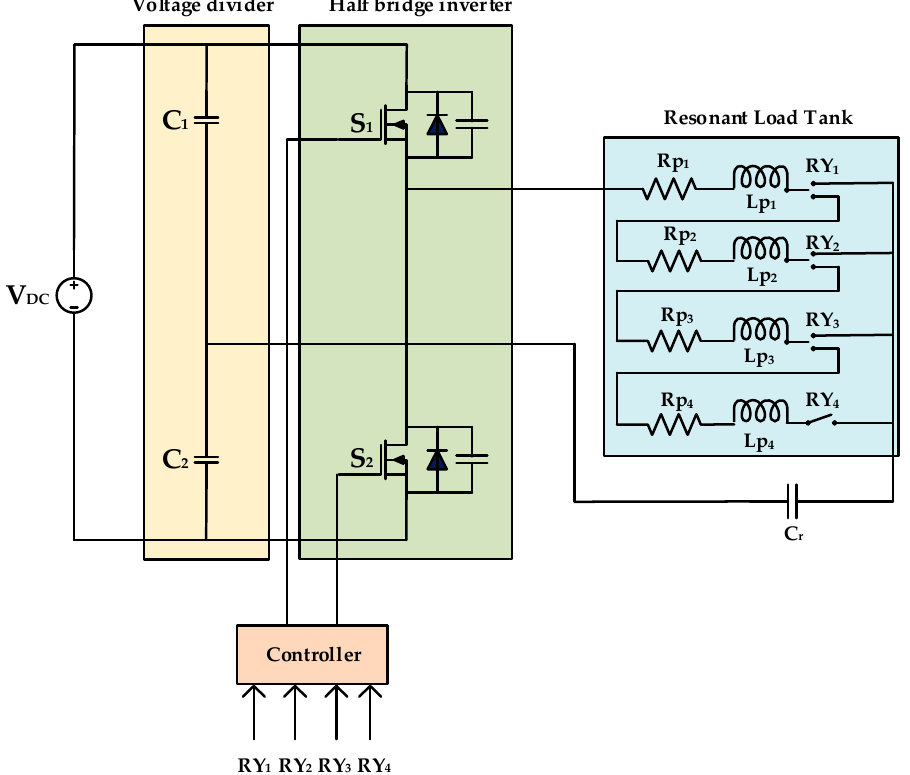
Figure 2. Circuit diagram of multi ‐ tapped half ‐ bridge series resonant inverter.